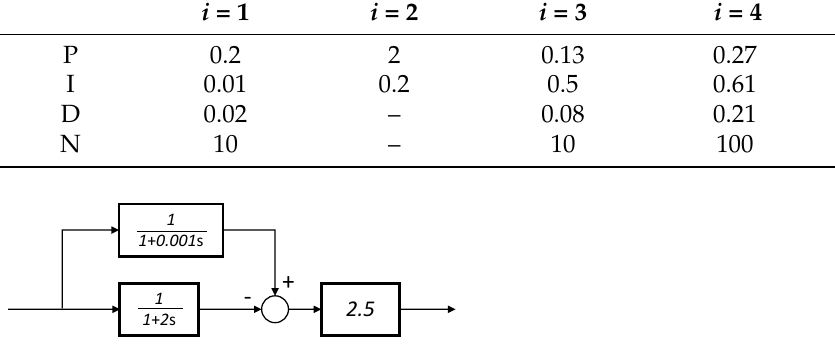
Figure 3. Layout of the industrial realization of the feedforward disturbance decoupling. The generated simulation data, including Gaussian noise, is presented in Figure 4. For each σ i variable, the noise parameters are selected randomly. In the case of the second variant, both Gauss and Cauchy disturbances are randomly selected, and the frequency of the added sinusoidal signal equals 30 Hz. The result of the above assumptions is presented